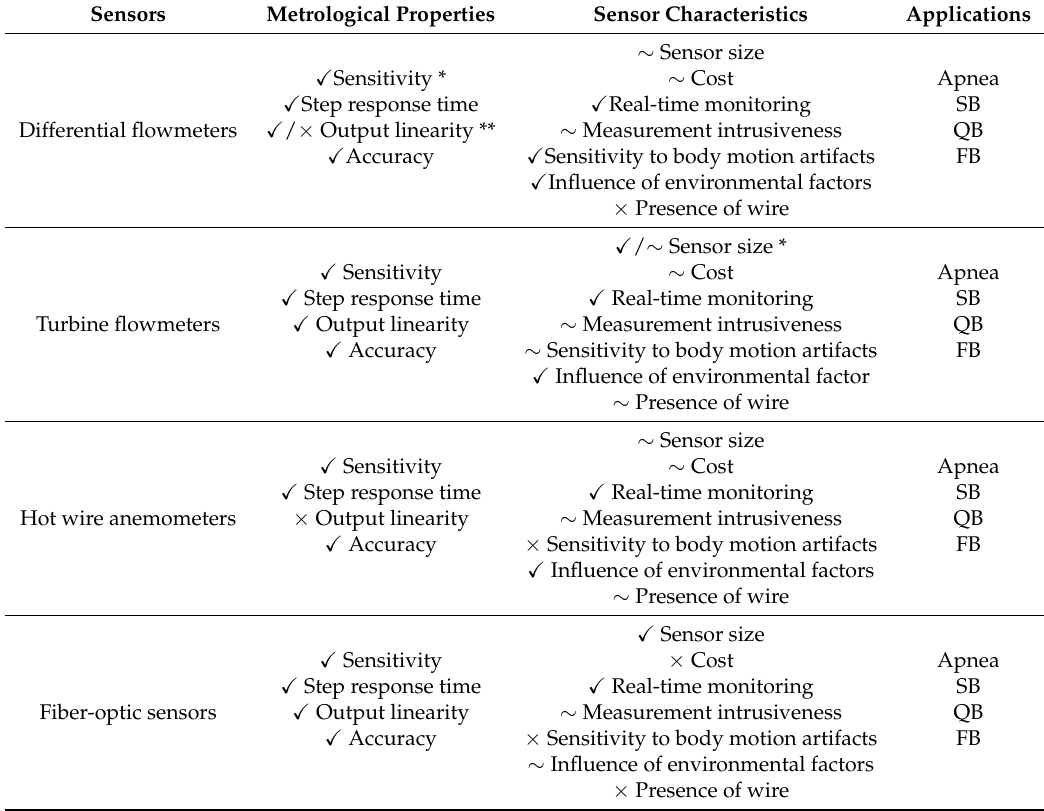
Table 1. Main metrological properties and characteristics related to airflow sensors specifically used for f R measurement. (cid:88) good to excellent, ∼ sufficient, ×